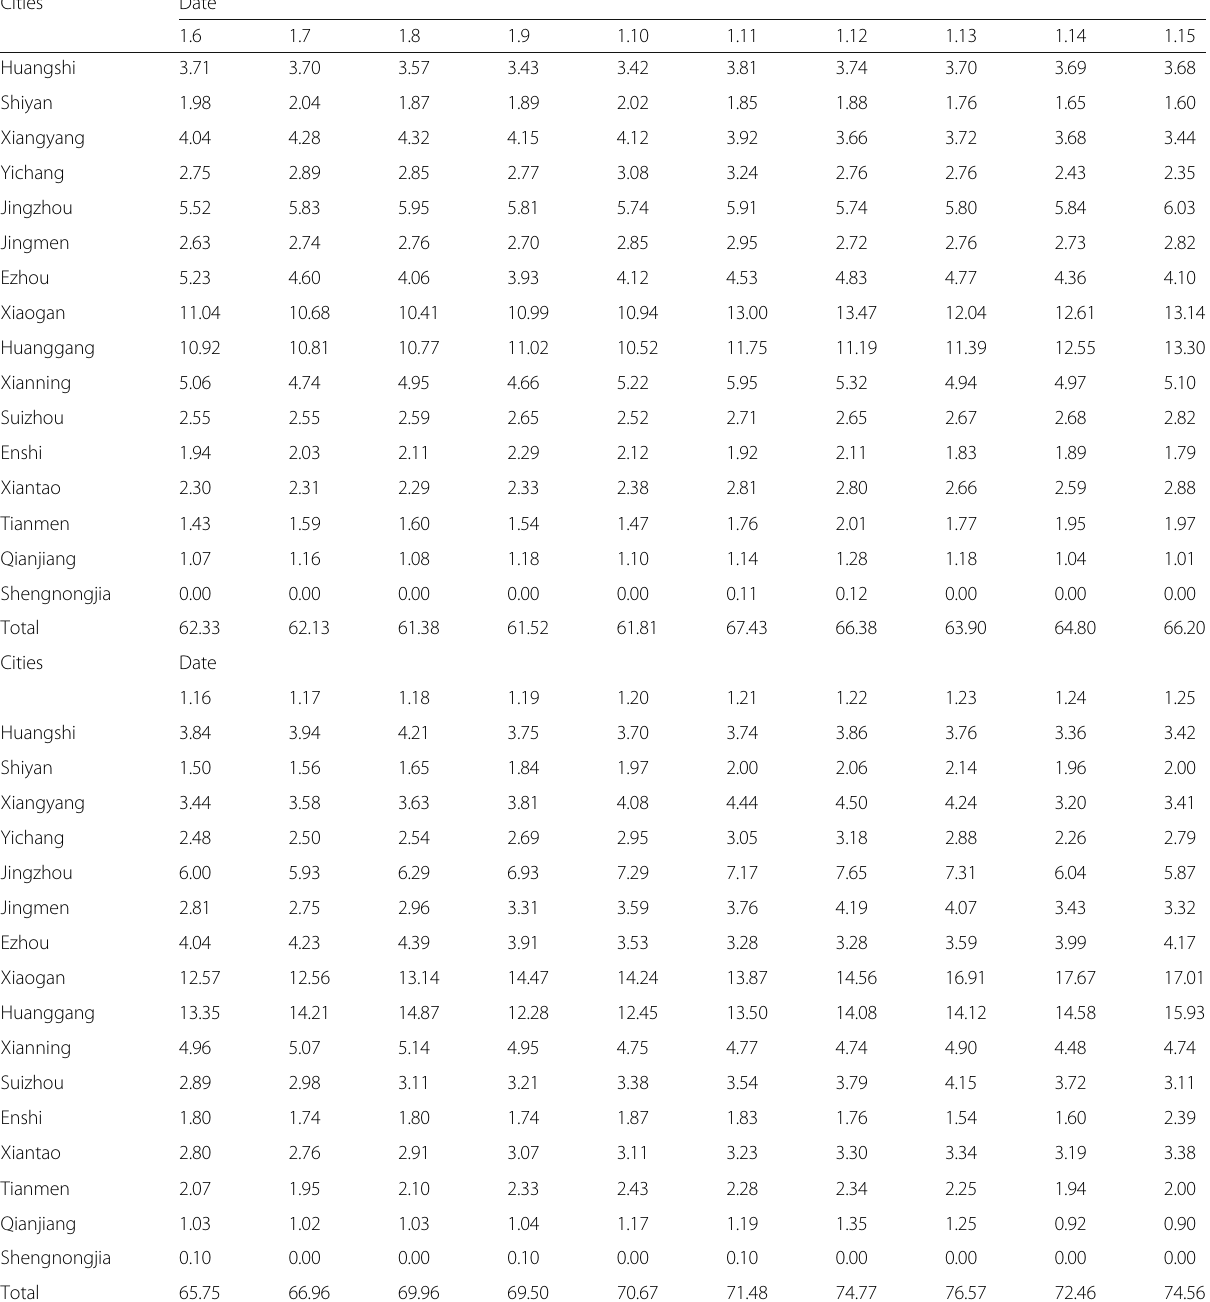
Table 3 Proportion of population moving from Wuhan to 16 prefecture-level cities in Hubei Province (%)